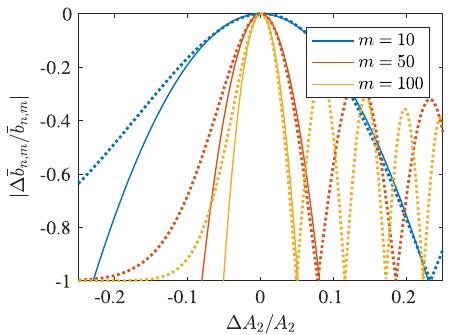
FIG. 2. Variation of bunching with deviations in B 1 from the approximate optimum in Eq. (4). A 1 ¼ 5 , A 2 ¼ 3 , a E ¼ 100 is assumed. Solid lines are from Eq. (7), dashed lines are from exact solutions.